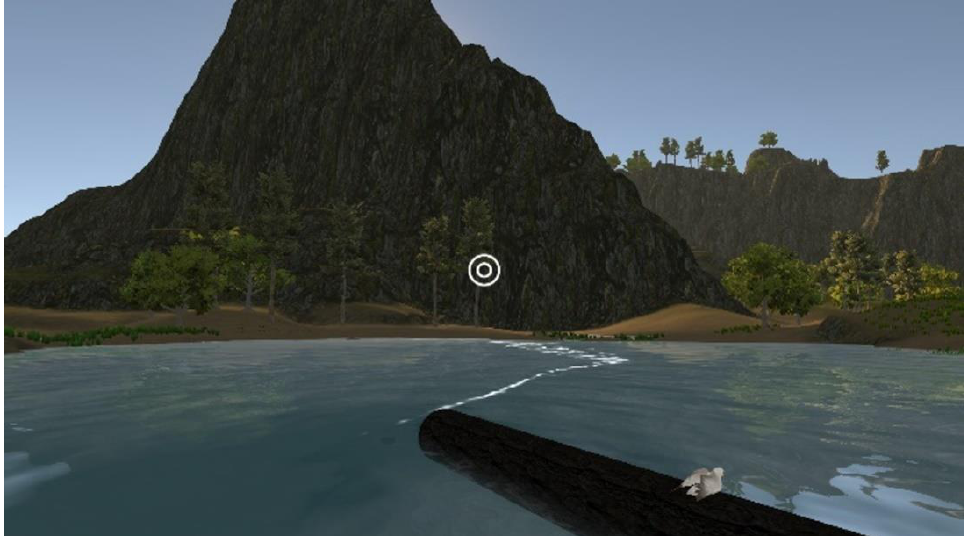
Figure 6. The first video clip presents 3D VR animation and human voices to tell a story about the content.